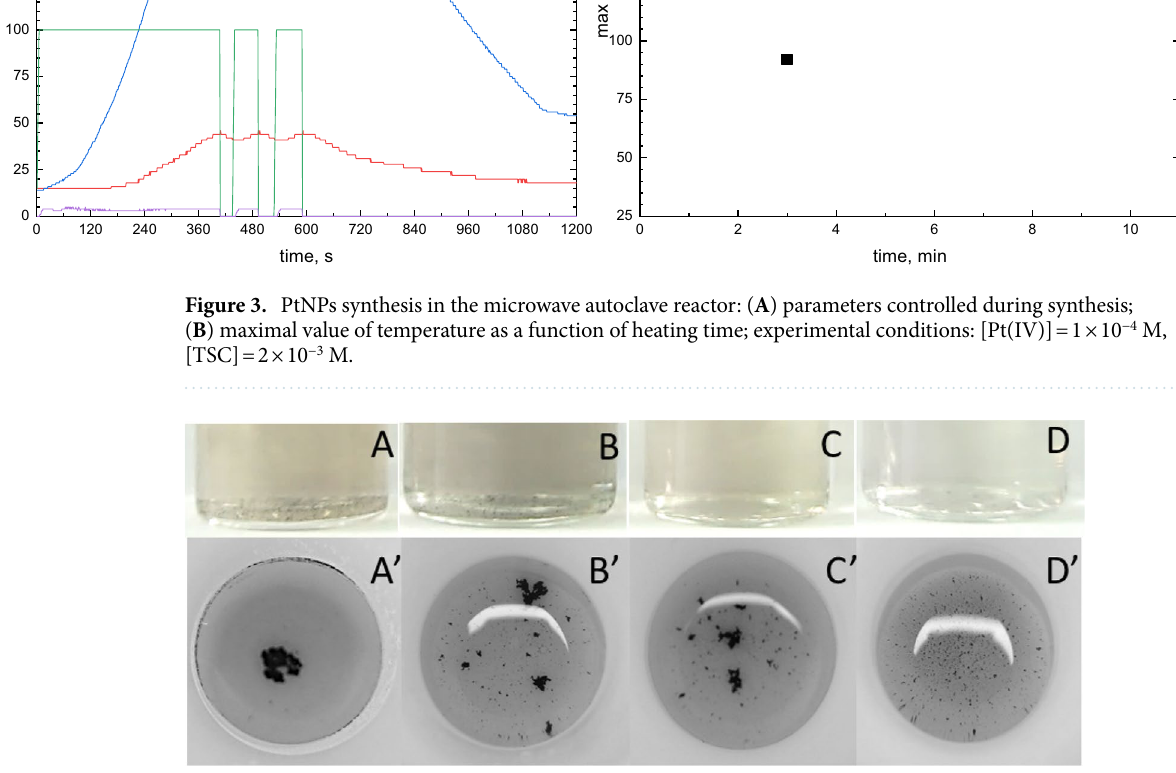
Figure 4. Photographical depiction of the reaction mixtures obtained after reduction in the batch ( A – D ), t = 60 min, T ≈ 100 °C and microwave autoclave reactor ( A ′ – D ′ ), t = 10 min, T max ≈ 225 °C; chemical composition of the reaction mixture: ( A , A ′ ) [Pt(IV)] = 5 × 10 −4 M, ( B , B ′ ) [Pt(IV)] = 2.5 × 10 −4 M, ( C , C ′ ) [Pt(IV)] = 1 × 10 −4 M, ( D , D ′ ) [Pt(IV)] = 5 × 10 −5 M, [TSC] = 200 × [Pt(IV)]